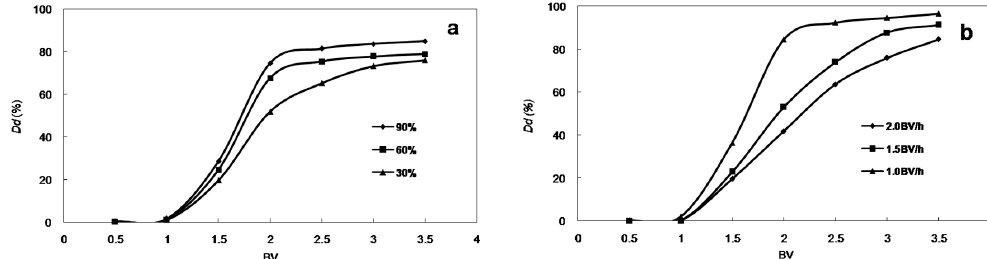
Figure 5. Dynamic desorption curves with ( a ) different ethanol volume fractions and ( b ) different current velocities (the ordinate is desorption ratio of anthocyanins). The flow rates investigated in this test were 1, 1.5 and 2 BV/h. At the flow rate of 1 BV/h, anthocyanins were totally desorbed with a solvent volume of 2.5 BV (Figure 5b). By comparison, at the flow rates of 1.5 and 2 BV/h, anthocyanins were totally desorbed with a solvent volume of 3 BV.